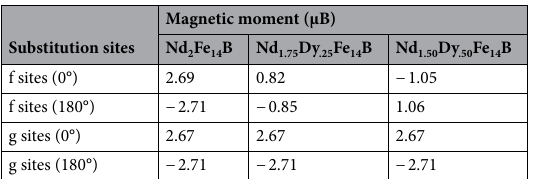
Table 1. Magnetic moment values of Nd 2 Fe 14 B and Nd 2−x Dy x Fe 14 B at “f” and “g” sites at rotating angle of 0° and